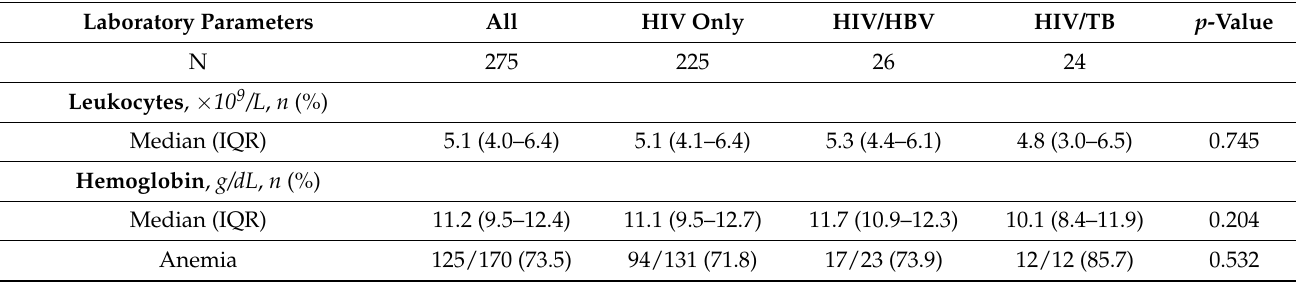
Table 2. Baseline laboratory parameters of study